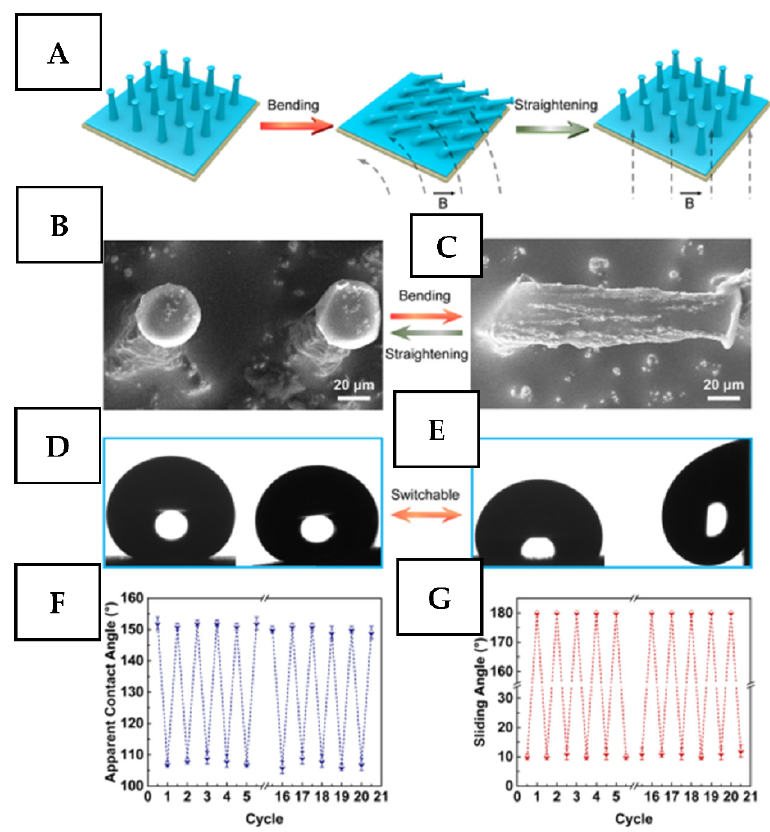
Figure 7. ( A ) A scheme of the reversible shape transformation between the upright state and the nearly flattened state. ( B , C ) Scanning electron microscopy images of the mushroom-like pillars in the upright and curved states, respectively. ( D , E ) Switchable wettability of the surfaces for hexadecane corresponding to ( B , C ), respectively. ( F , G ) Reversible variations in the apparent contact angle and sliding angle of hexadecane through repeated bending and recovery processes, respectively. Reprinted with permission from ref. [120]. Copyright 2019 American Chemical Society.